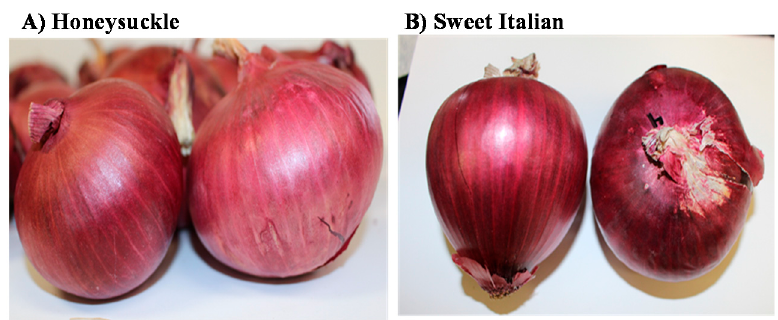
Figure 1. Onion varieties ( A ) honeysuckle and ( B ) sweet